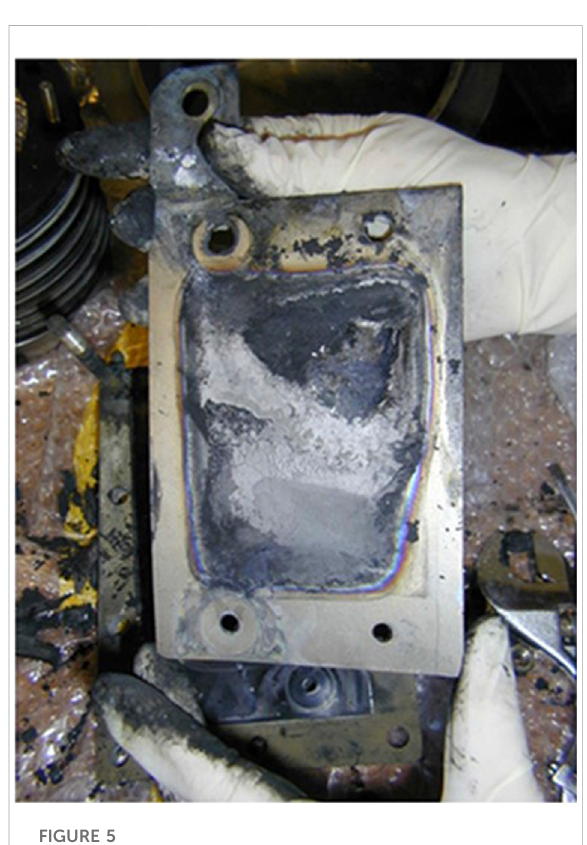
FIGURE 5 Bipolar/cell plate that has been damaged by a thermal event. Reproduced with permission from Millet et al.